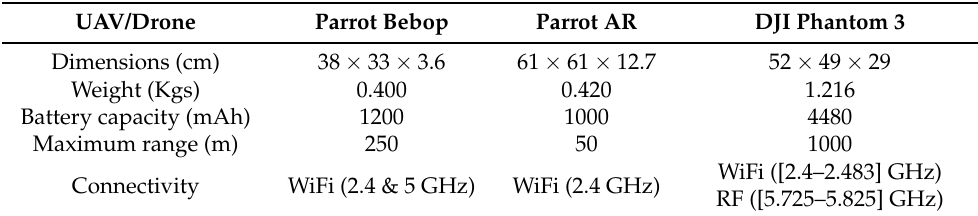
Table 4. Features of the selected